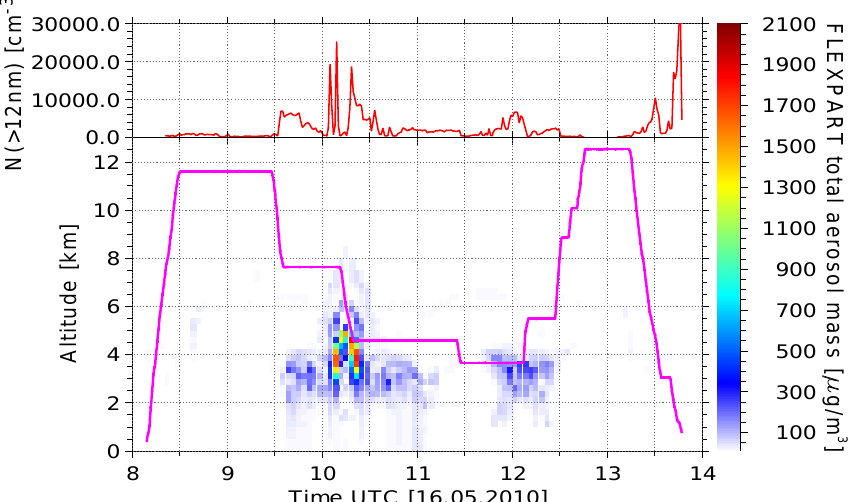
Fig. 10. Particle measurement and model comparison for flight on 16 May 2010. Upper panel: CPC particle number concentration for particles between 12nm and 2µm. Lower panel: simulated vertical distribution of the ash along the flight track from the FLEXPART model. The magenta line gives the CARIBIC pressure altitude as reported by the aircraft. The modelled total ash particle mass is colour-coded. Ash particle mass concentrations of less than 10µgm − 3 are not